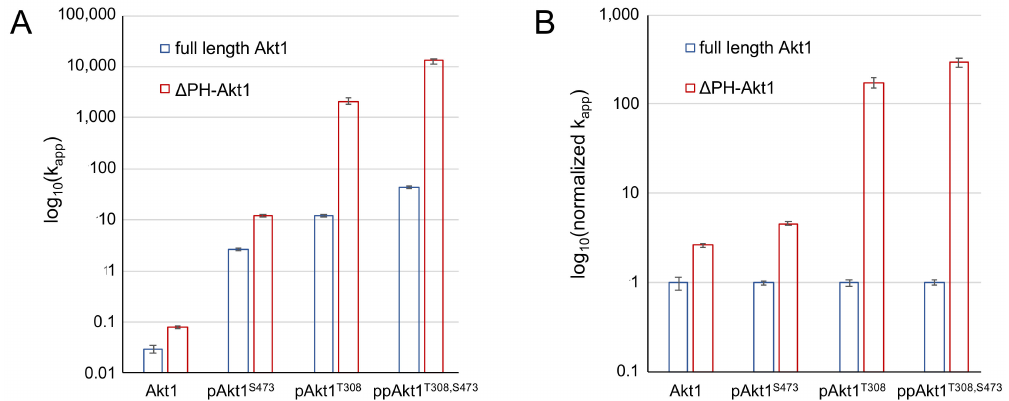
Figure 5. Impact of PH domain on the activity of differentially phosphorylated Akt1. ( A ) Apparent catalytic rates ( k app ) and ( B ) normalized k app values of full-length Akt1 variants (blue) and ∆ PH-Akt1 variants (red) are shown. Error bars represent one standard deviation of triplicate